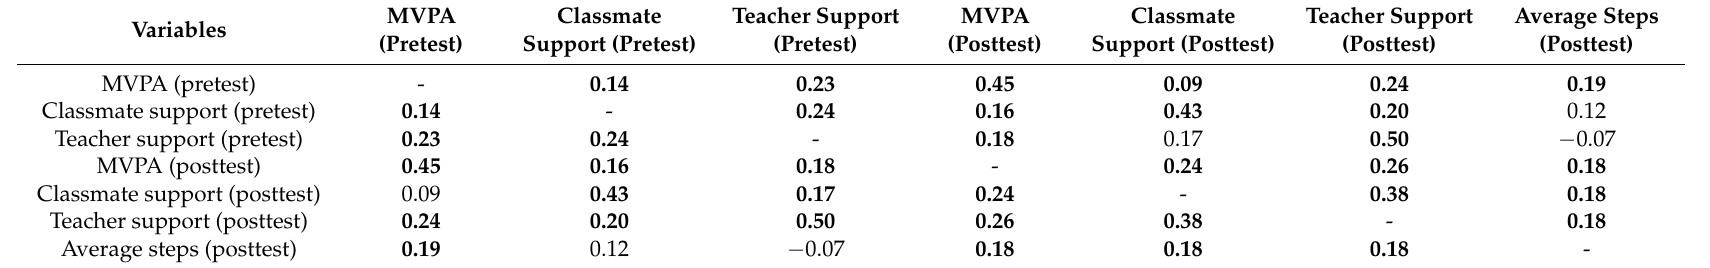
Table 3. Correlation matrix between MVPA, Classmate support, Teacher support in pretest and posttest and Average steps in